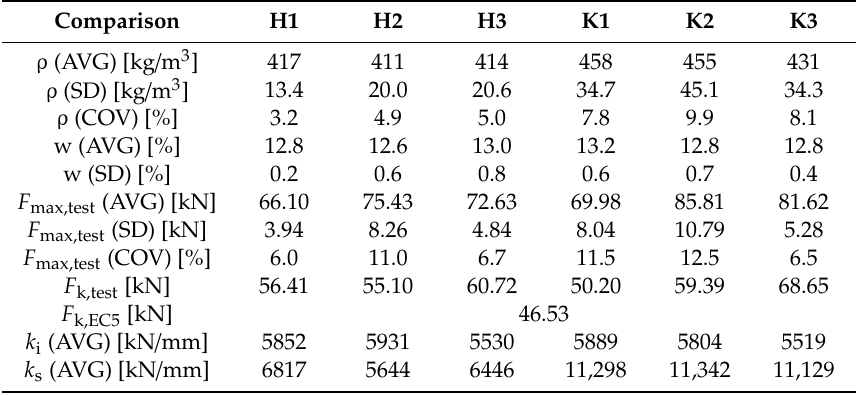
Table 2. Values of bulk density, moisture content, maximum force, characteristic force and slip moduli for all types of